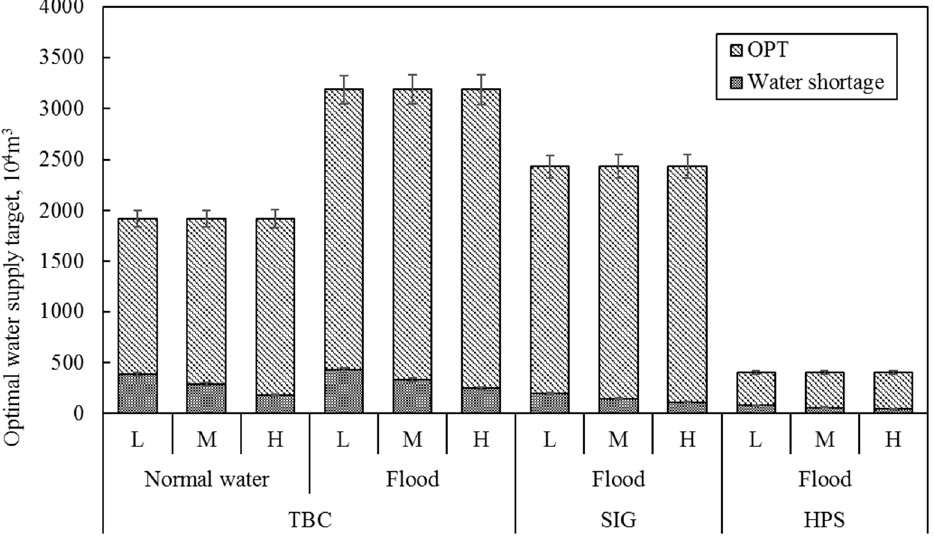
Figure 3. Water supply by different water diversion methods at each water intake of the Momoge National Nature Reserve (MNNR) in different scenarios.